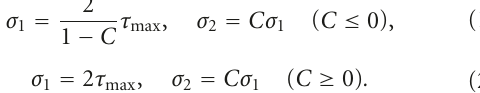
adhered to this surface, the third principal stress in the foil σ 3